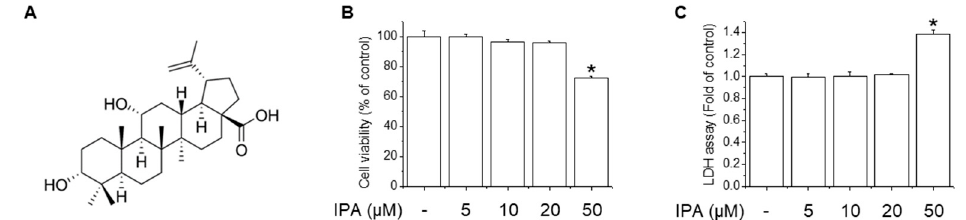
Figure 1. Effect of IPA on the cell viability and cytotoxicity of RAW264.7 cells. ( A ) Chemical structure of IPA. RAW264.7 cells were treated with 5–50 μ M IPA for 24 h. Cell viability ( B ) and cytotoxicity ( C ) were measured by MTT and LDH assay. Data are the mean ± SD of three independent experiments. * Significantly different from the control at p < 0.01.